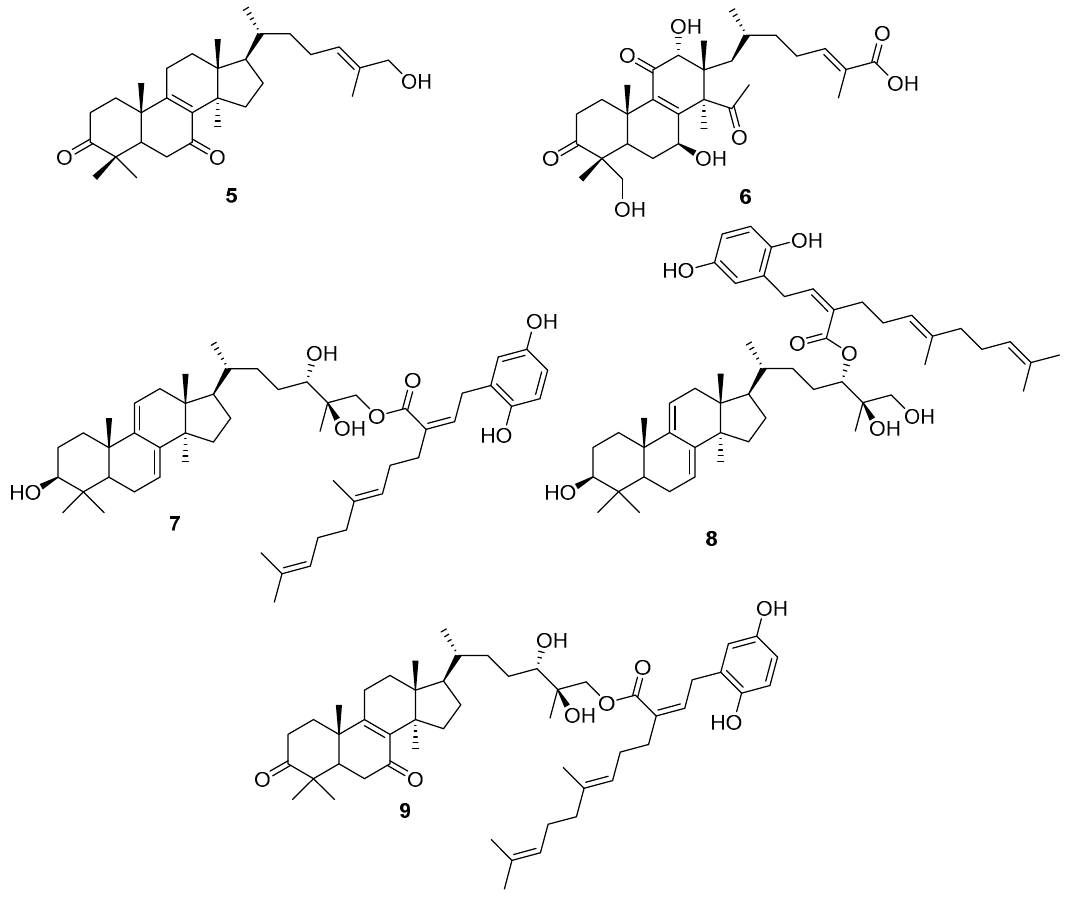
Figure 3. The structures of trirepenoids showed strong inhibitory activity against α -glucosidase.